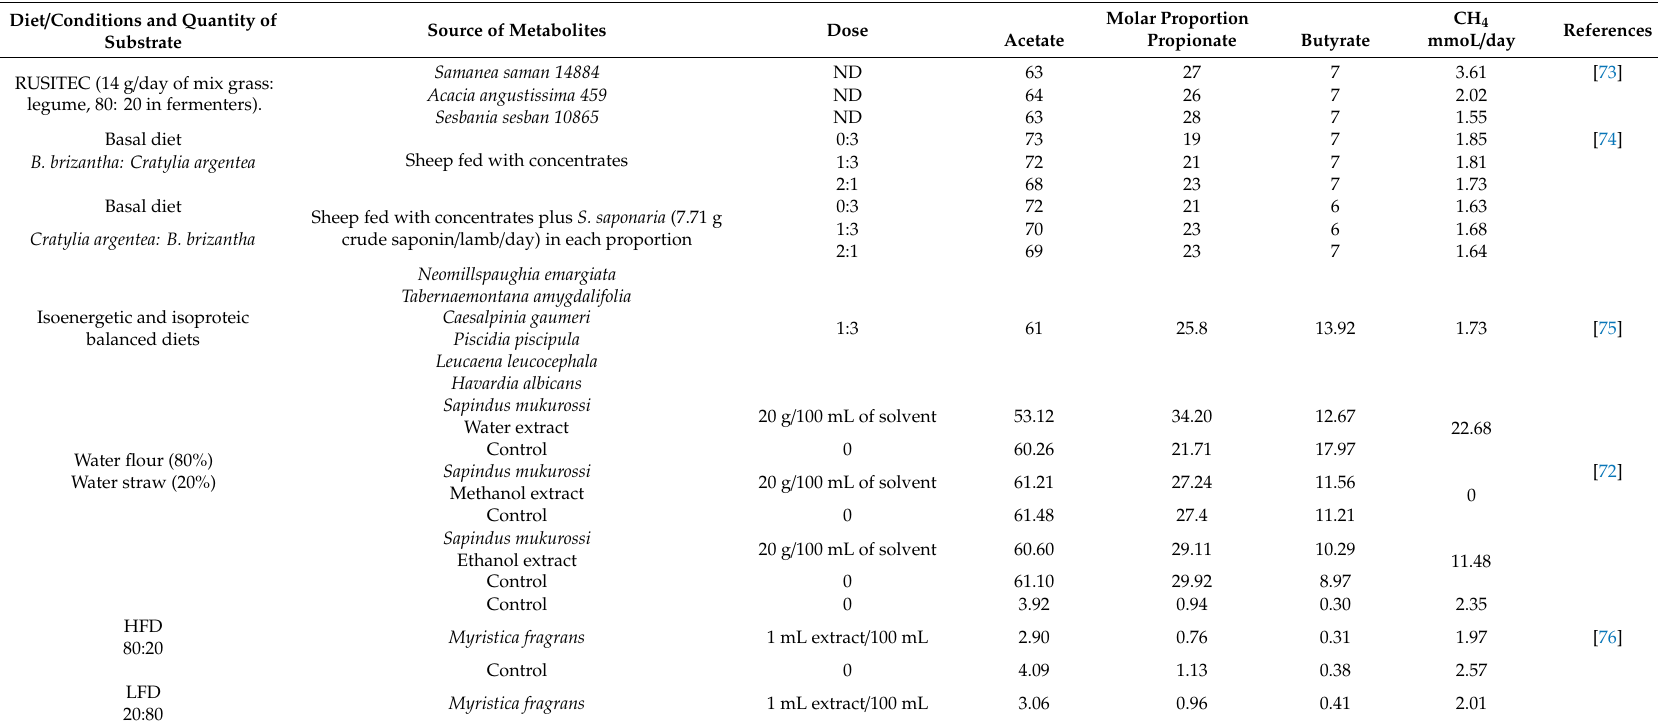
Table 5. E ff ect of metabolites from tropical trees on molar proportions of volatile fatty acids and CH 4 production in the